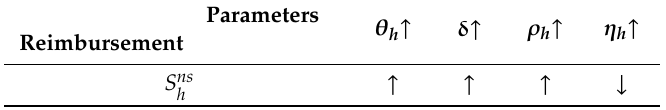
Table 2. Relationship between superior hospital insurance reimbursement and parameters.